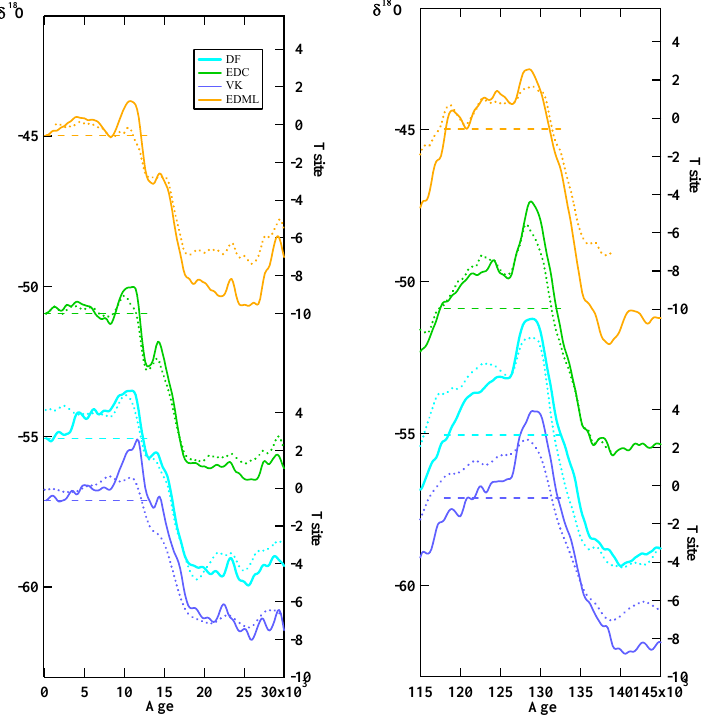
Fig. 5. Comparison between the initial isotopic records (‰, left axis, bold lines) and the site temperature ( ◦ C, right axis, same temperature scaling for all records, dotted lines) estimated after correction for sea water isotopic composition and moisture source correction taking into account deuterium excess data, for EDC and EDML (Stenni et al., 2010b), Vostok (Vimeux et al., 2001a) and Dome F (Uemura et al., 2004; Kawamura et al., 2007). The resolution of the Tsite records varies between 200 years (EDC and EDML), 300 years (DF) and 400 years (Vostok). They have been normalized with respect to the last millennium and smoothed using a binomial filter to highlight only multi-millennial trends. (a) Current interglacial, and (b) last interglacial. With this approach, strong increases in deuterium excess during interglacials at Vostok and DF (not shown here) appear to account for long- term interglacial isotopic